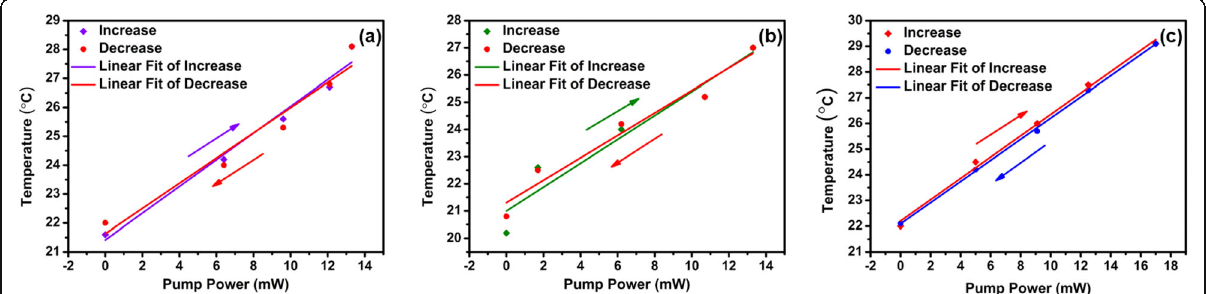
Fig. 10 Temperature as a function of pump power for a violet laser, b green laser, and c red